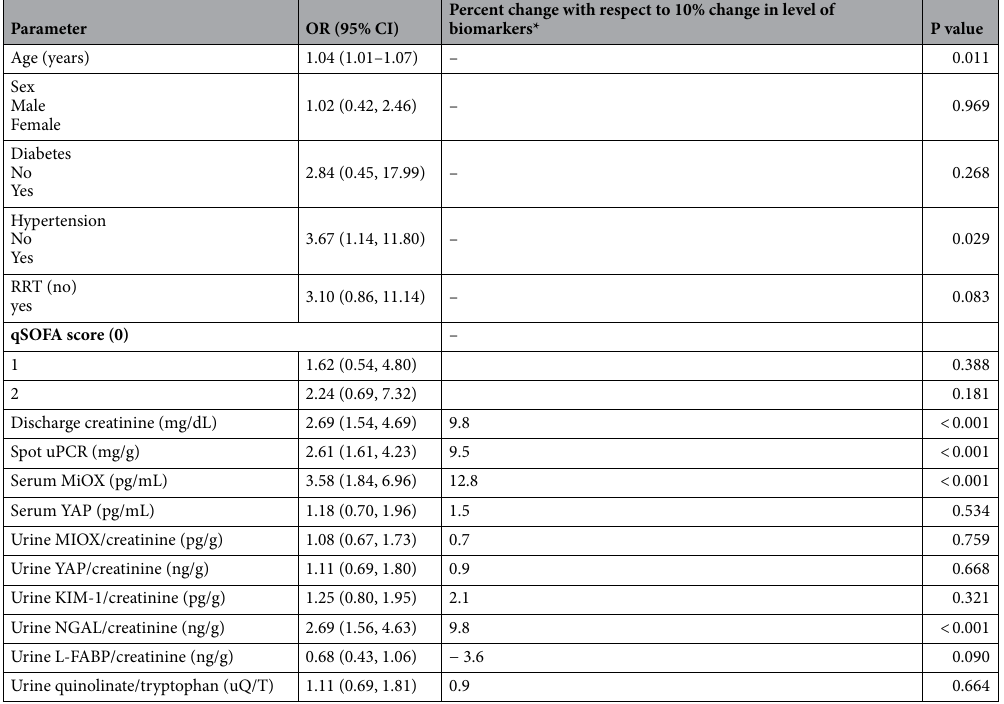
Table 3. Unadjusted logistic regression of clinical parameters, serum and urine biomarkers at hospital discharge and for the association of renal outcome (progression to CKD from CA-AKI). Continuous variables except for age, are standardized log transformed. uPCR urine protein creatinine ratio, MIOX myo-inositol oxygenase, YAP Yes-associated protein, KIM-1 kidney injury molecule-1. NGAL neutrophil gelatinase- associated lipocalin, L-FABP liver-type fatty acid binding protein. *Percentage change with respect to 10% change in levels of biomarkers is represented for the standardized log transformed variable computed from odds ratio (OR) by formula; 100 ×(exp(log(OR) × log(1.1)) − 1).